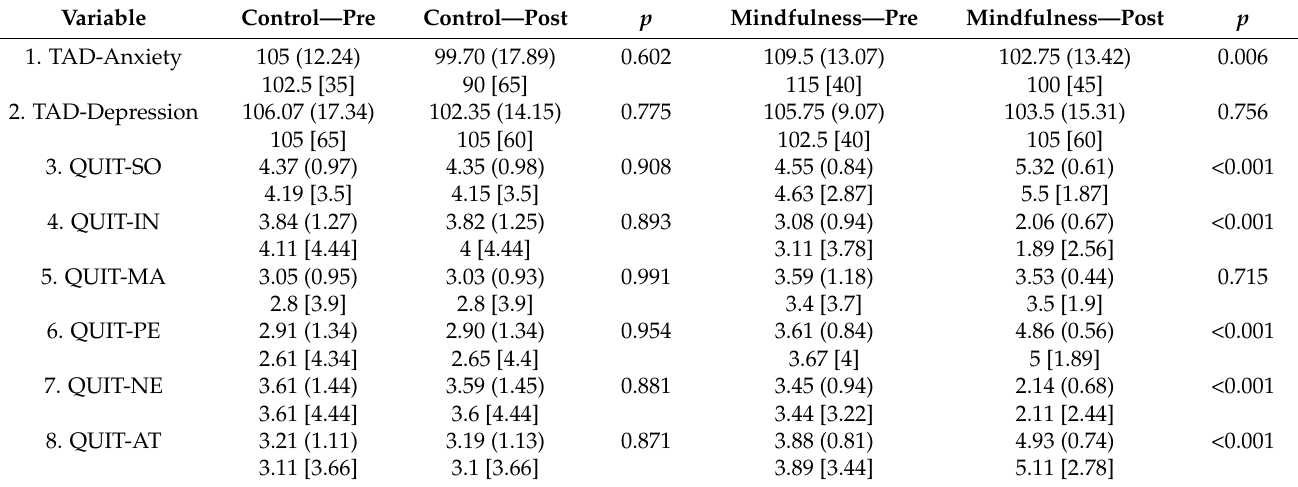
Table 2. Group comparisons among the study measures within Mindfulness ( n = 23) and Control ( n = 18) samples assessed pre-intervention and